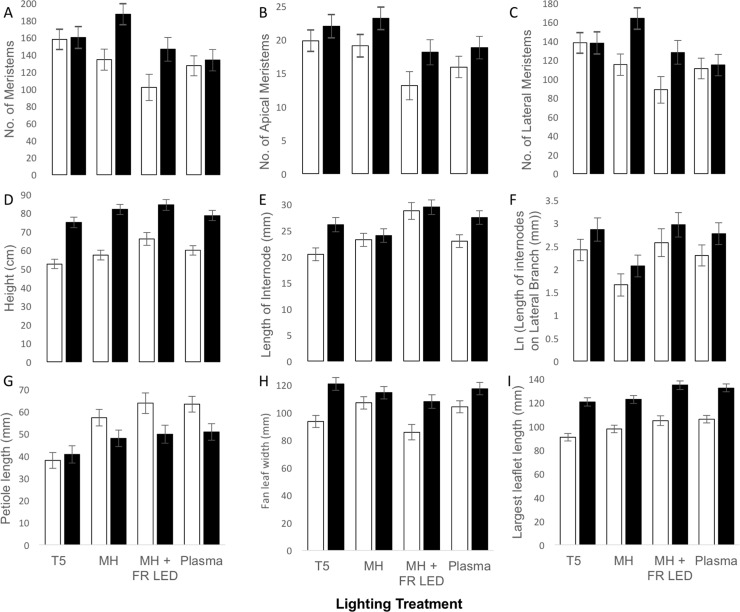
Comparison of nine key traits to predict clonal yield and robustness of “mother” Cannabis sativa plants grown under one of four lighting treatments.Lighting treatments included T5 fluorescent bulbs, metal halide lamps (MH), metal halide lamps augmented with far red LEDs (MH + FR LED), and Plasma lamps. Averages represent trait means of 48 mother plants from two cultivars (White = Bubba Kush, Black = Ghost Train Haze); error bars represent the SE of the mean.